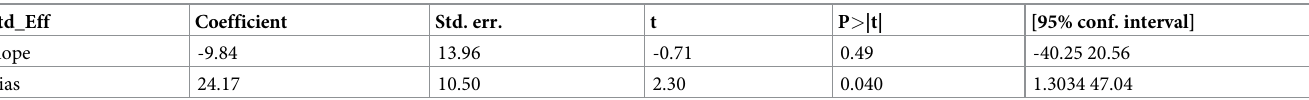
Table 3. The table to chek the publication bias objectively. Std_Eff